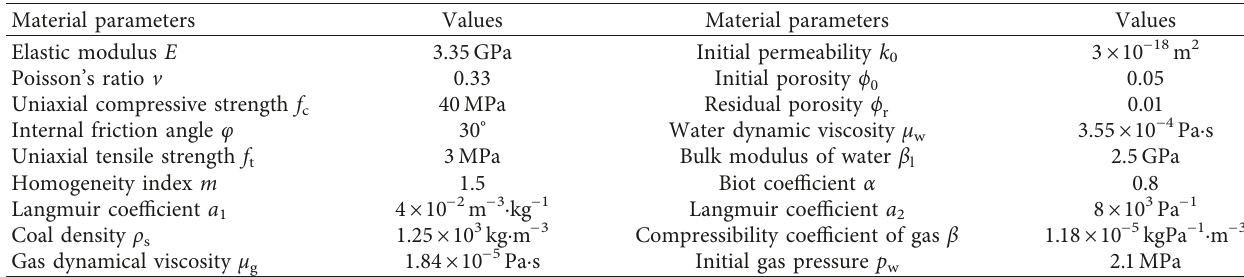
Figure 10: Distribution diagram of cracks evolution during hydraulic fracturing process ( m � 20). (a) Step 12_99. (b) Step 14_55. (c) Step 15.5_28. (d) Step 18.5_9. Table 3: Parameters for the numerical